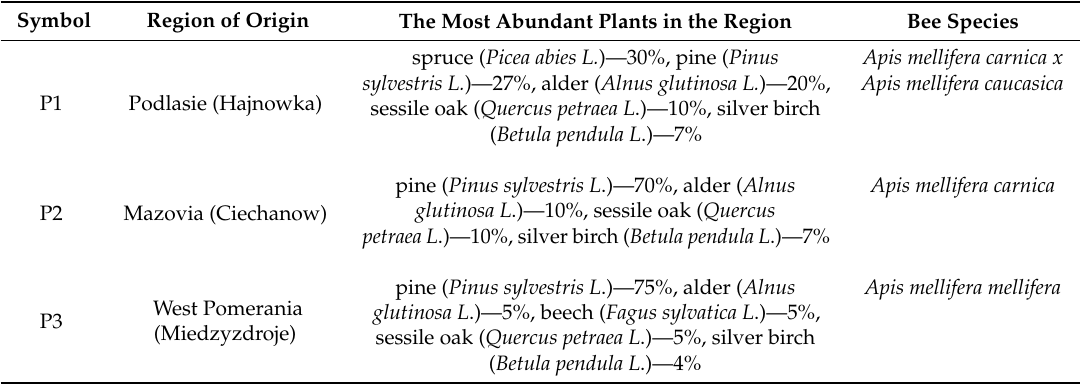
Table 4. Geographical origin of the Polish propolis examined.